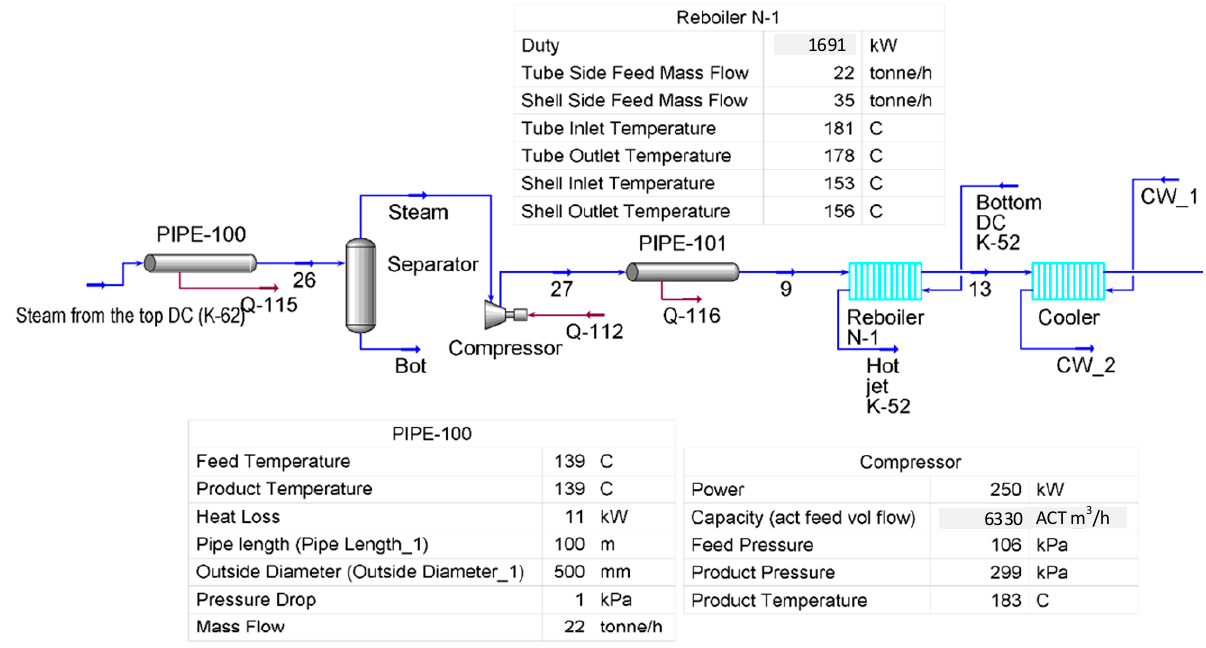
Figure 8. Hysys model of HP integration between columns K-62 and K-52 (Option No. 1).